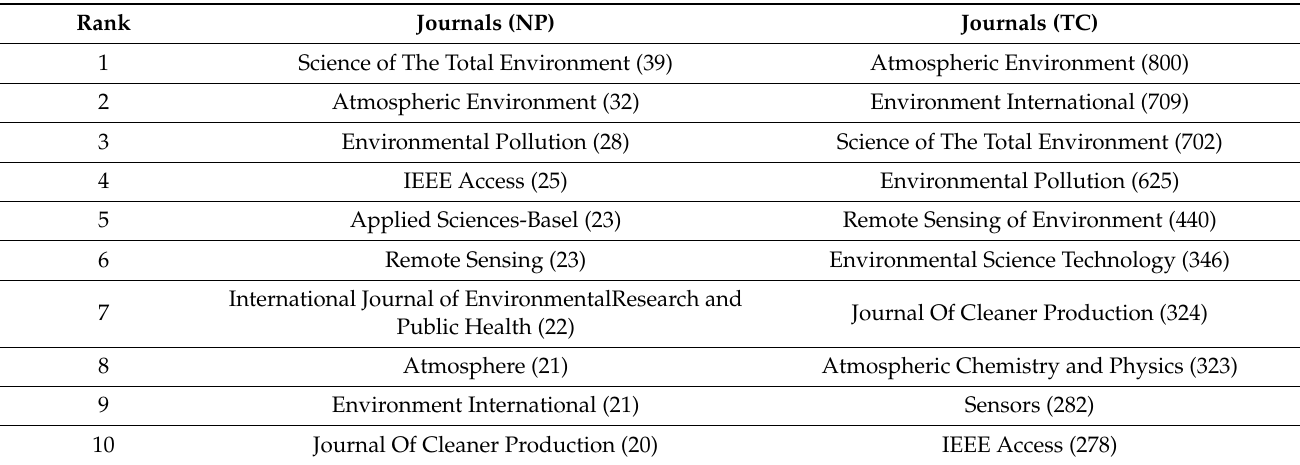
Figure 8. Citation Analysis of Published Papers [22,57–59,62–70]. Table 7. TopTen most influential